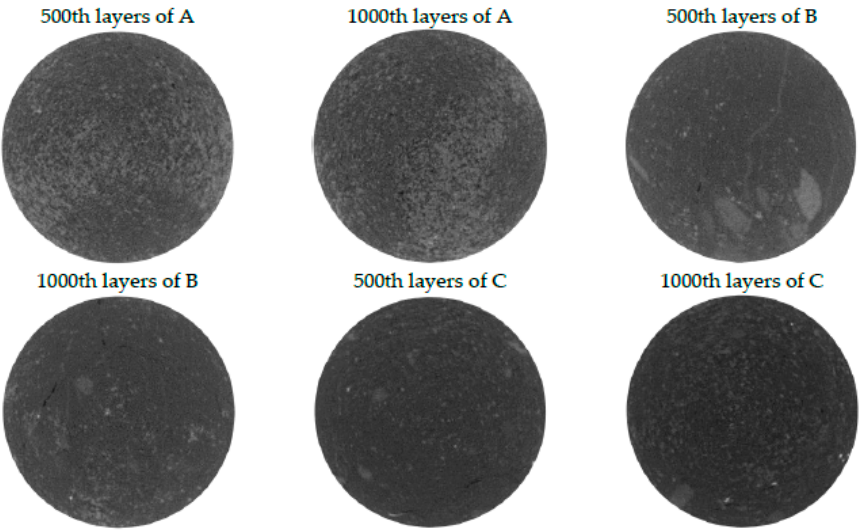
Figure 11. CT-scan grayscale imaging of oil shale after pyrolysis.